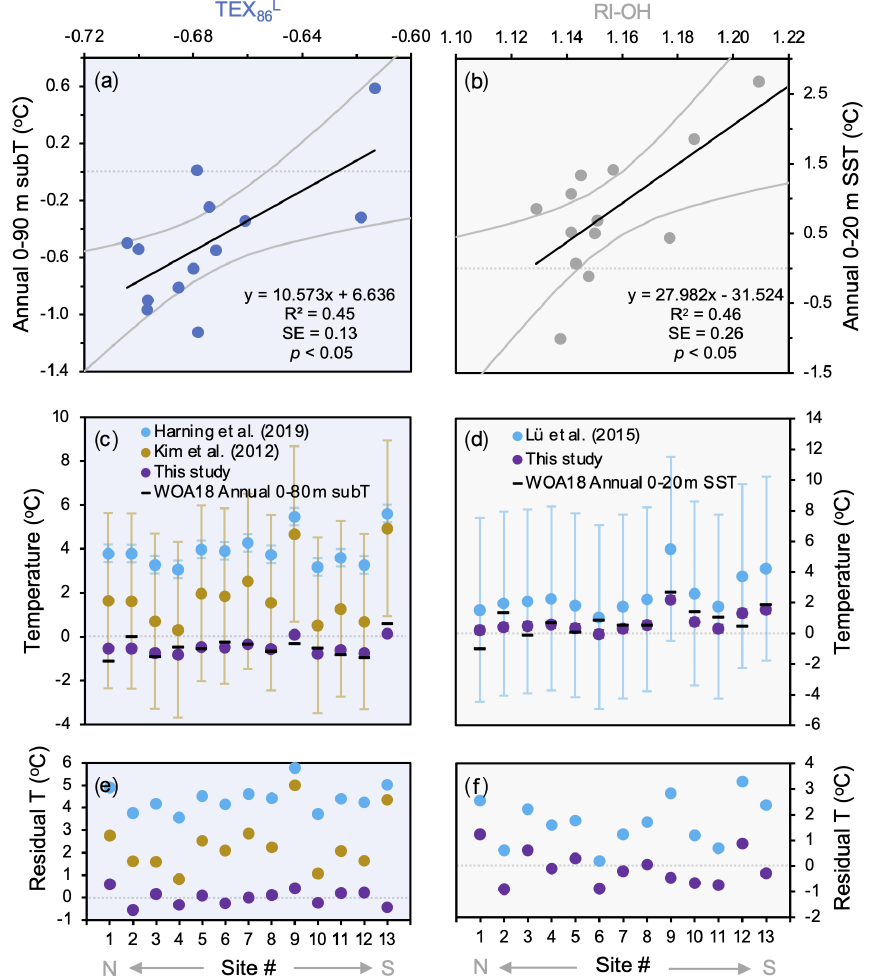
Figure 8. GDGT- and OH-GDGT temperature calibrations for this study’s dataset ( n = 13). Shown are (a) TEX L versus annual 0–90m 86 sub T ; (b) RI-OH (OH-GDGTs) versus annual 0–20m SST; (c) TEX L sub T estimates based on Iceland (blue, Harning et al., 2019), global 86 (yellow, Kim et al., 2012), and Baffin Bay (purple, this study) calibrations against WOA18 annual 0–90m sub T (black dashes, Locarnini et al., 2018); (d) RI-OH SST estimates based on global (blue, Lü et al., 2015) and Baffin Bay (purple, this study) calibrations against WOA18 annual 0–20m SST (black dashes, Locarnini et al., 2018). Panels (e) and (f) show residuals of calibration estimates and WOA18 data for TEX L and RI-OH, respectively. The x axis refers to site number (see Fig. 1 and Table 86